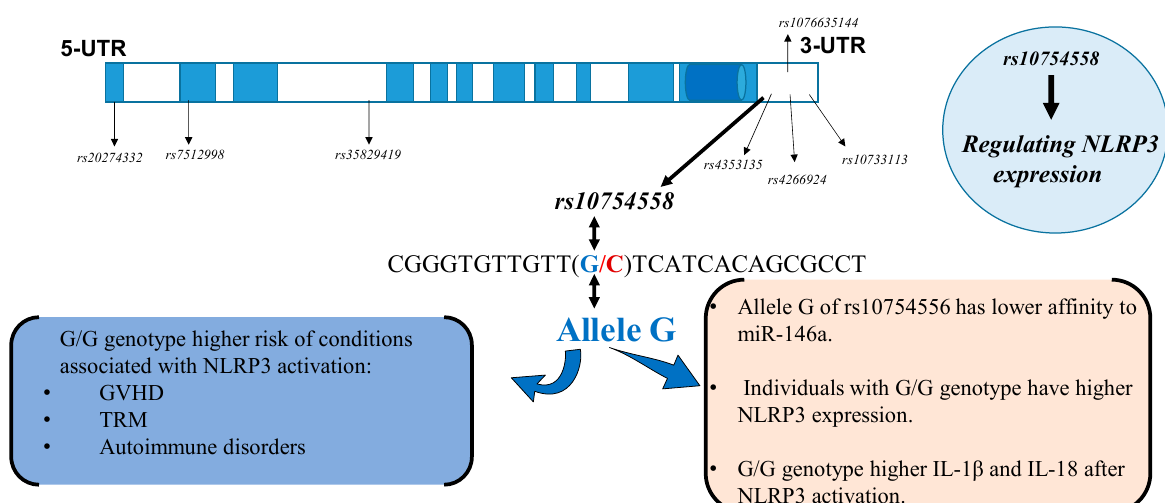
Figure 2. Schematic representation of rs10754558 and other polymorphisms in the NLRP3 gene with reported associations with susceptibility to various inflammatory diseases. Introns of the NLRP3 gene are displayed as blue boxes and exons are displayed as white boxes (not to scale). The SNP rs10754558 is the 3 ′ -untranslated region (3 ′ -UTR) of the NLRP3 gene and regulates gene expression. The G allele is a gain of function that decreases the affinity of NLRP3 to negative regulators (the microRNA, miR146a) and, consequently, individuals possessing the G allele have higher NLRP3 expression and secrete higher levels of cytokines in response to NLRP3 activation.